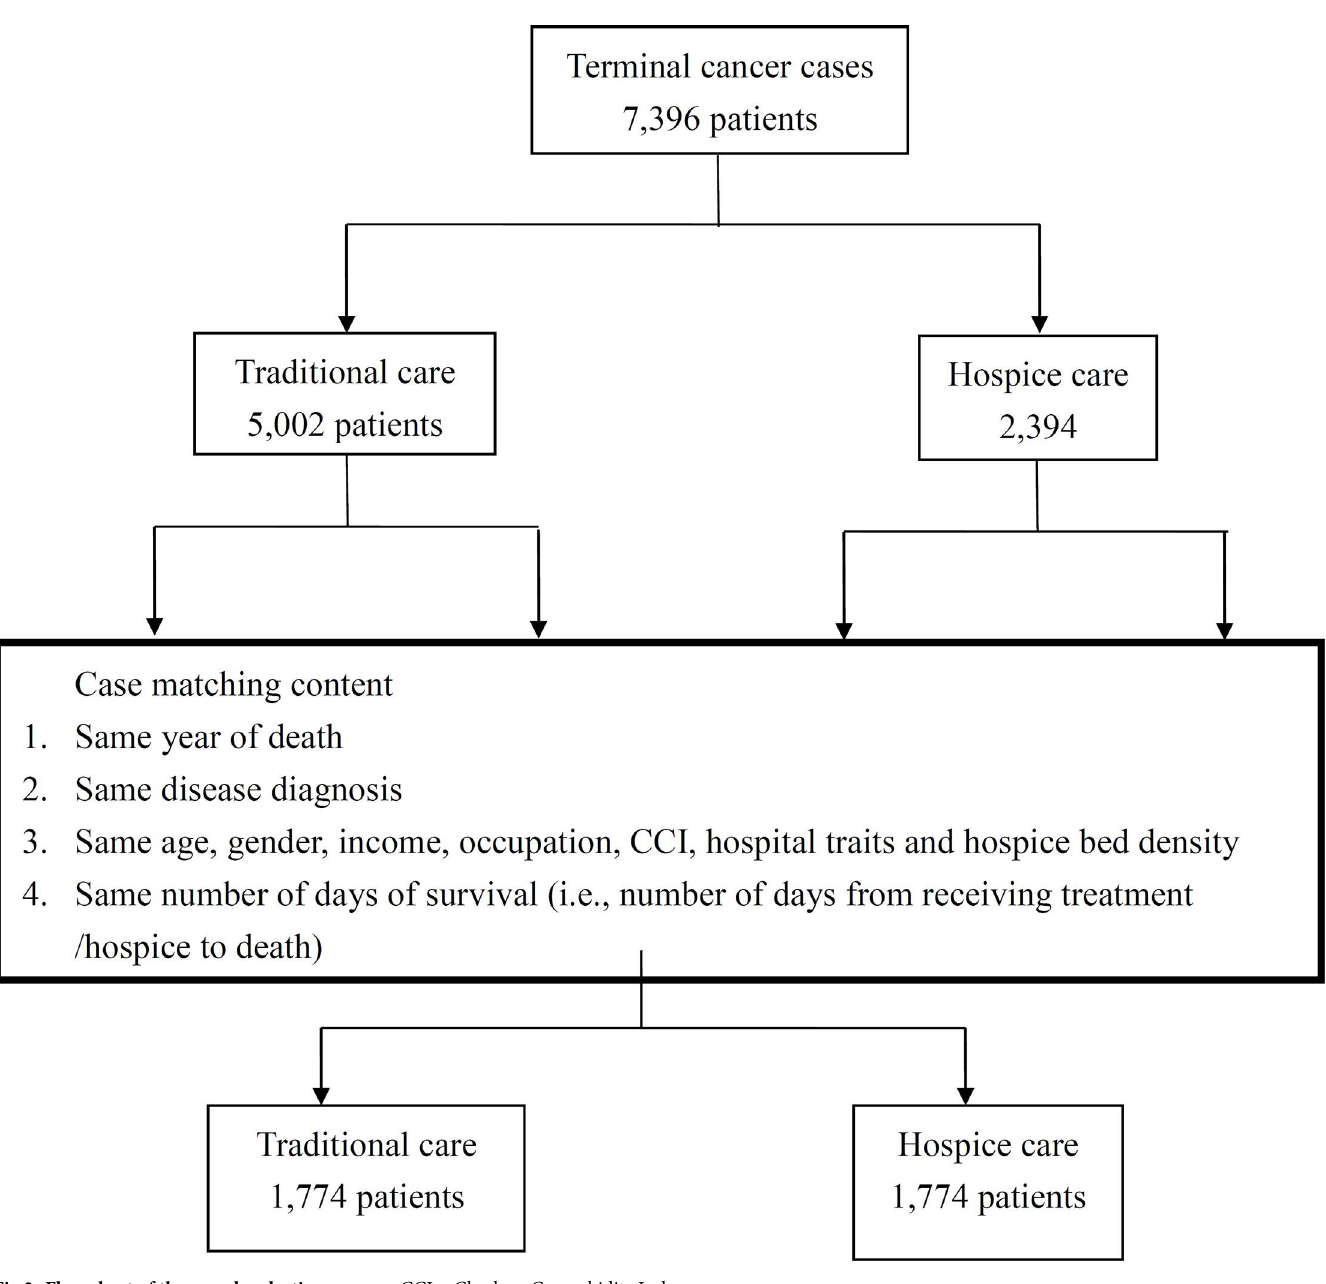
Fig 3. Flow chart of the sample selection process. CCI = Charlson Comorbidity